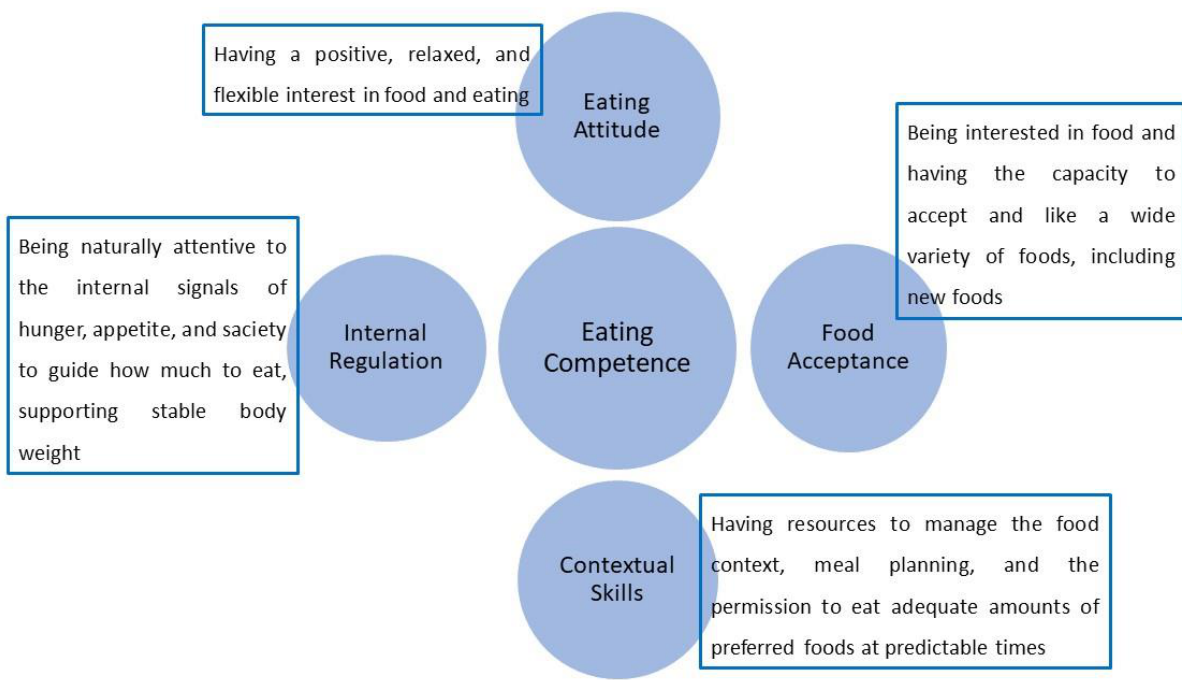
Figure 1. The four components of Eating Competence.